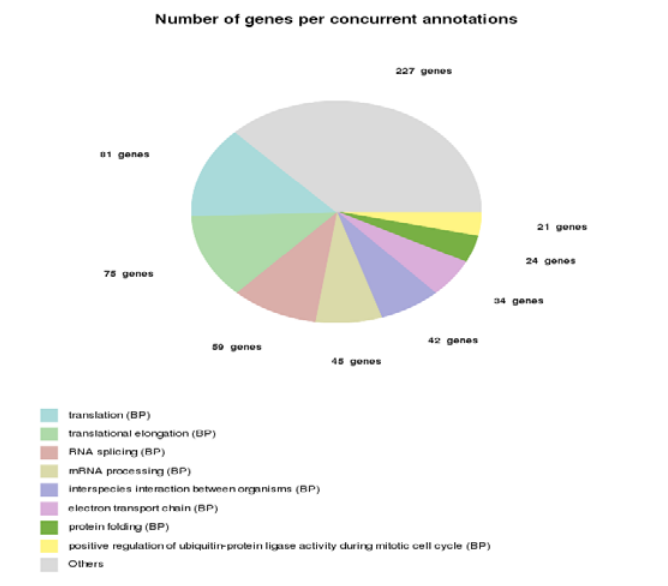
Figure 1: Number of genes per concurrent annotation in hypergeometric for GO biological process (generated by GeneCodis2) Table 3: Enrichment terms of housekeeping genes using hypergeometric